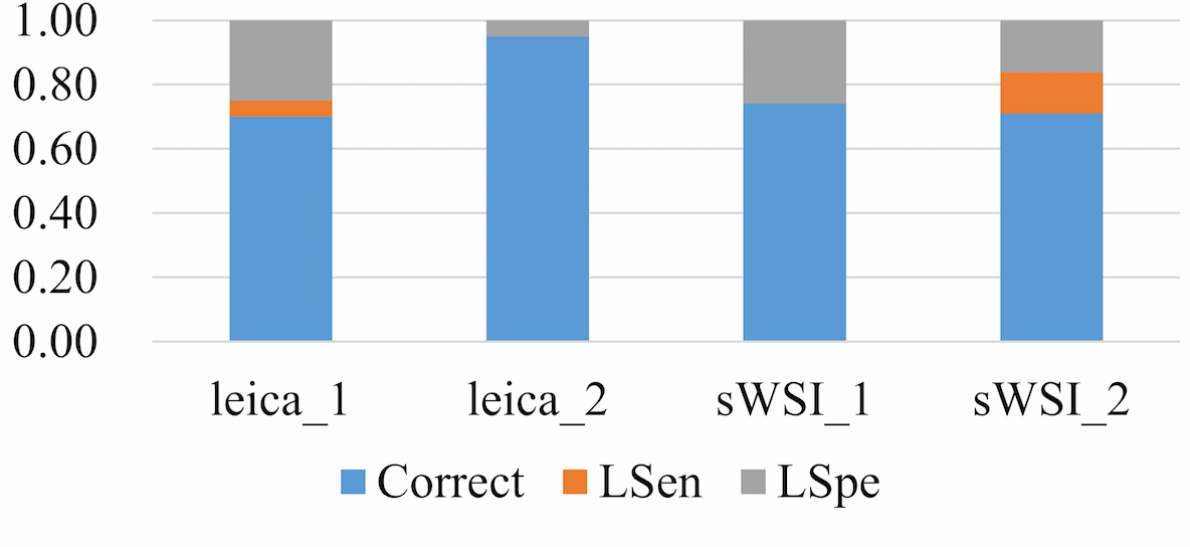
Figure 9. Performance based on scanner and sWSI virtual slides. Sample type: uterine corpus. LSen: low sensitivity; LSpe: low